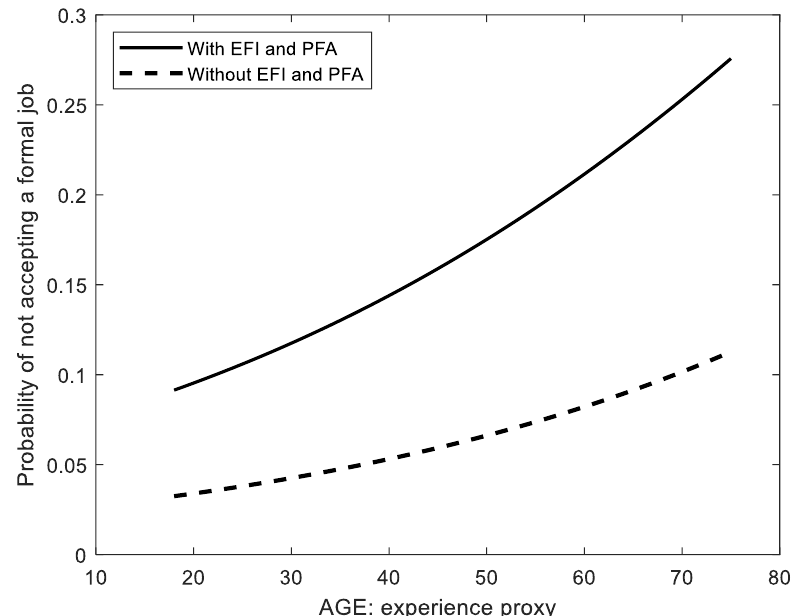
Figure 3. EFI and PFA withdrawal effect on the probability of not accepting a formal